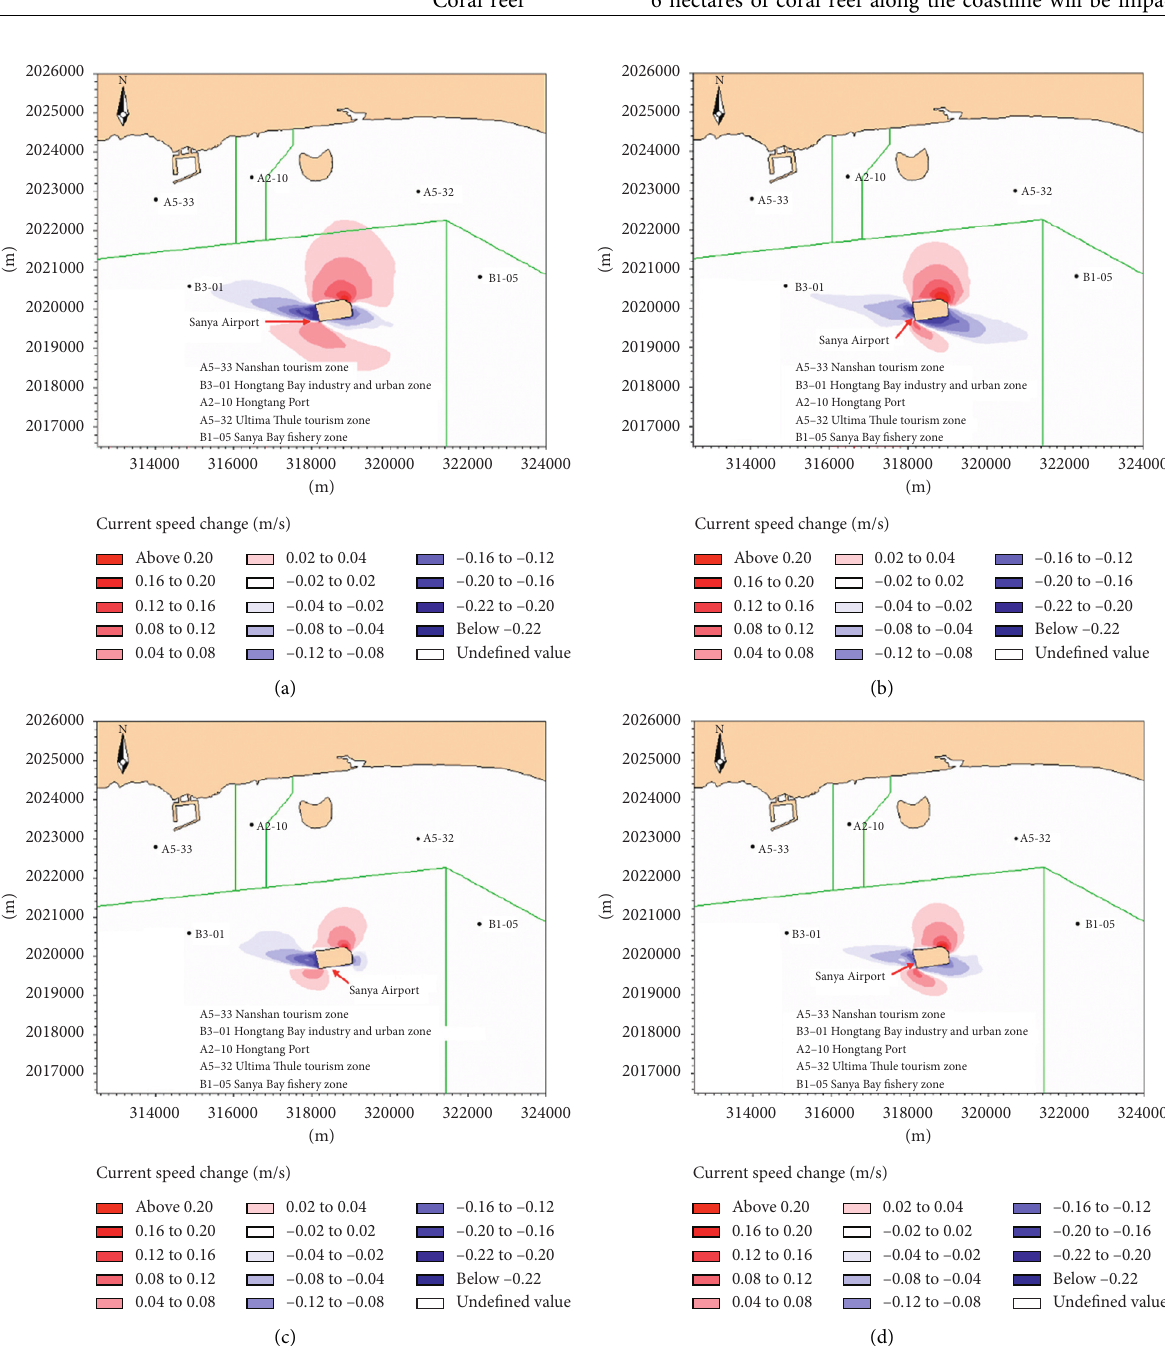
Figure 4: Tidal current speed change: (a) high tide rising; (b) high tide ebbing; (c) neap tide rising; (d) neap tide